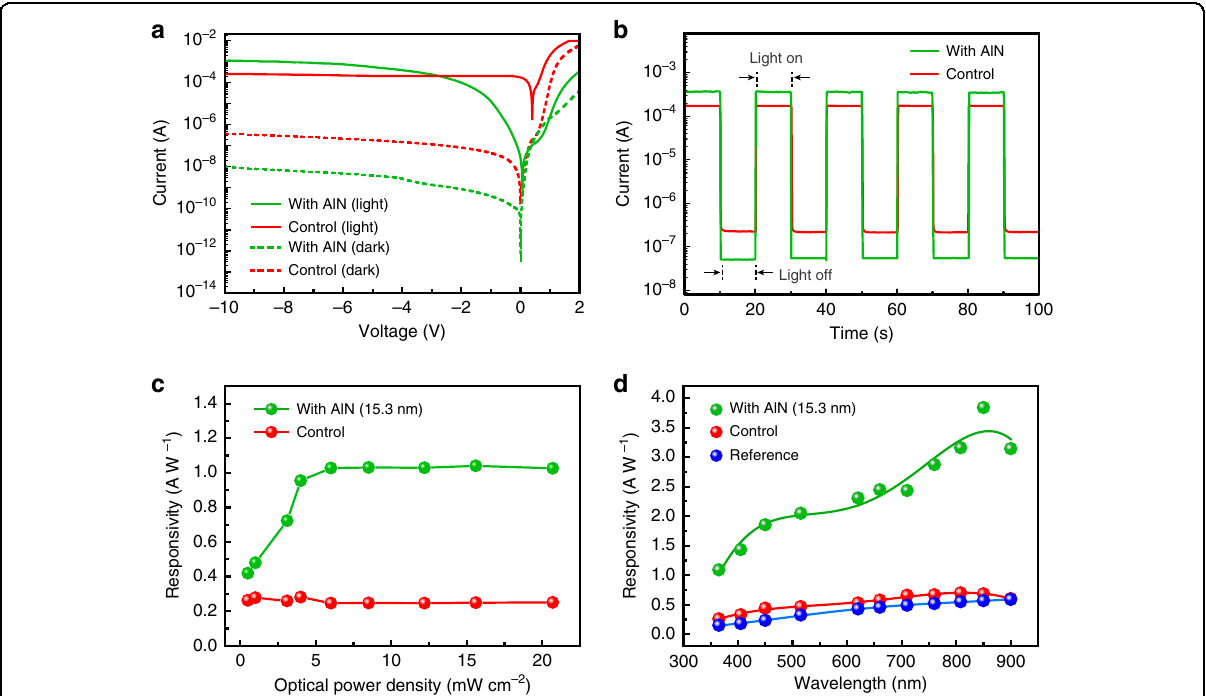
Fig. 3 Photo-detection performance of the GIS devices. a The I-V characterizations of GIS tunneling photodetector with 15.3-nm AlN comparing with the conventional graphene/n-Si heterojunction photodetector under dark and light illumination. b Time-dependent photo-response for the GIS device under − 10 V and 365-nm light illumination (12.2 mW cm − 2 ). c Optical power-dependent responsivity in the GIS tunneling photodetector with the comparison to the control device without tunneling layer under 365-nm light illumination at a bias of − 10 V. d Spectra-dependent photocurrent responsivity of the GIS tunneling photodetector with 15.3-nm AlN tunneling layer at a bias of − 10 V, comparing with the control and reference